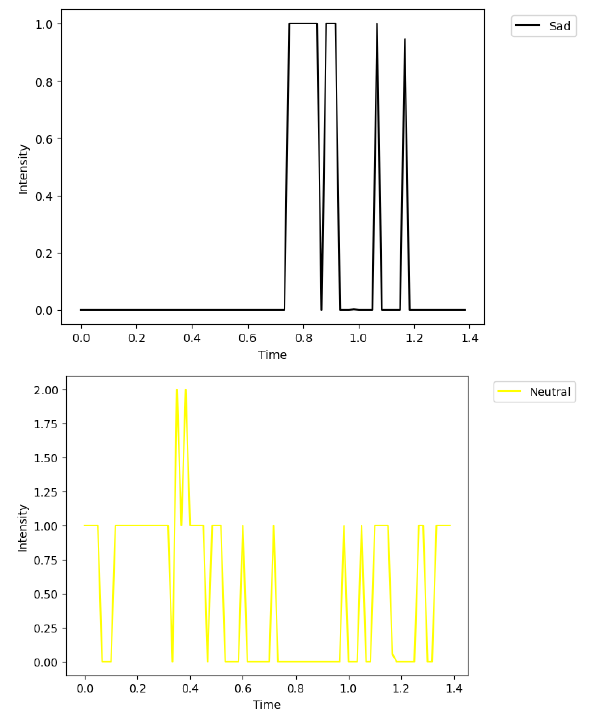
Fig. 11. Emotions Detected vs